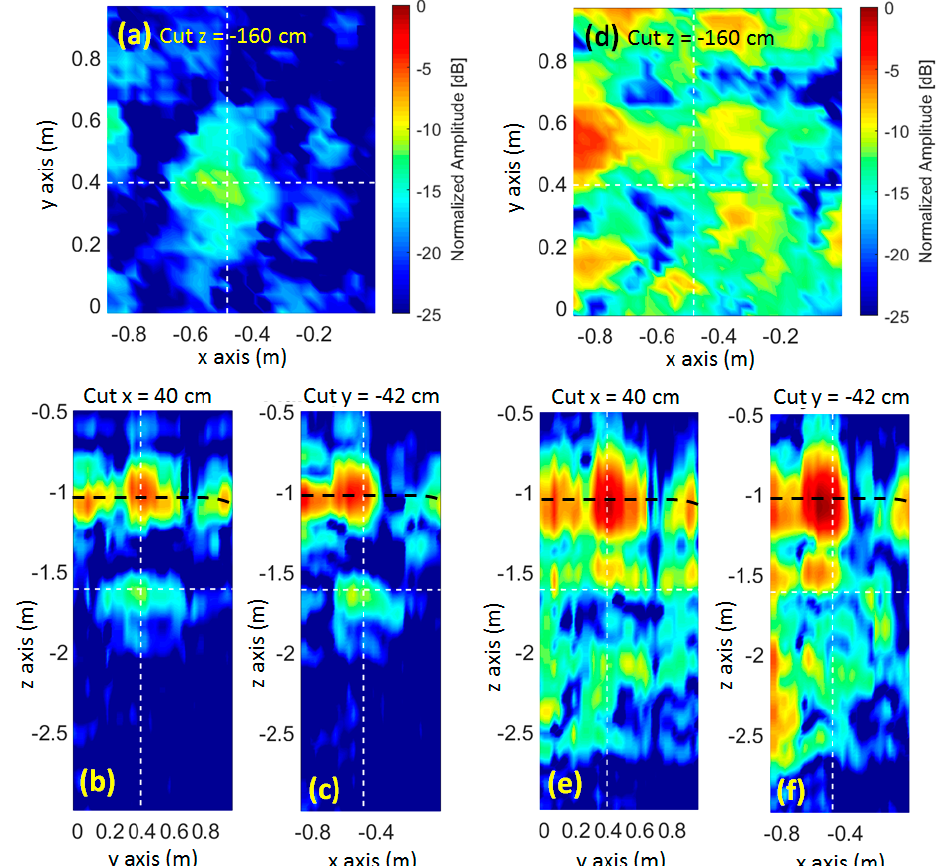
Figure 17. Reflectivity normalized amplitude, in dB. Metal box buried at 25 cm depth. Applying LPA phase center compensation: cut z = − 160 cm ( a ), cut x = 40 cm ( b ), cut y = -42 cm ( c ). Without applying LPA phase center compensation: cut z = − 160 cm ( d ), cut x = 40 cm ( e ), cut y = − 42 cm ( f ). The z = 0 position is defined at the plane where the LPA antennas are attached to the payload.